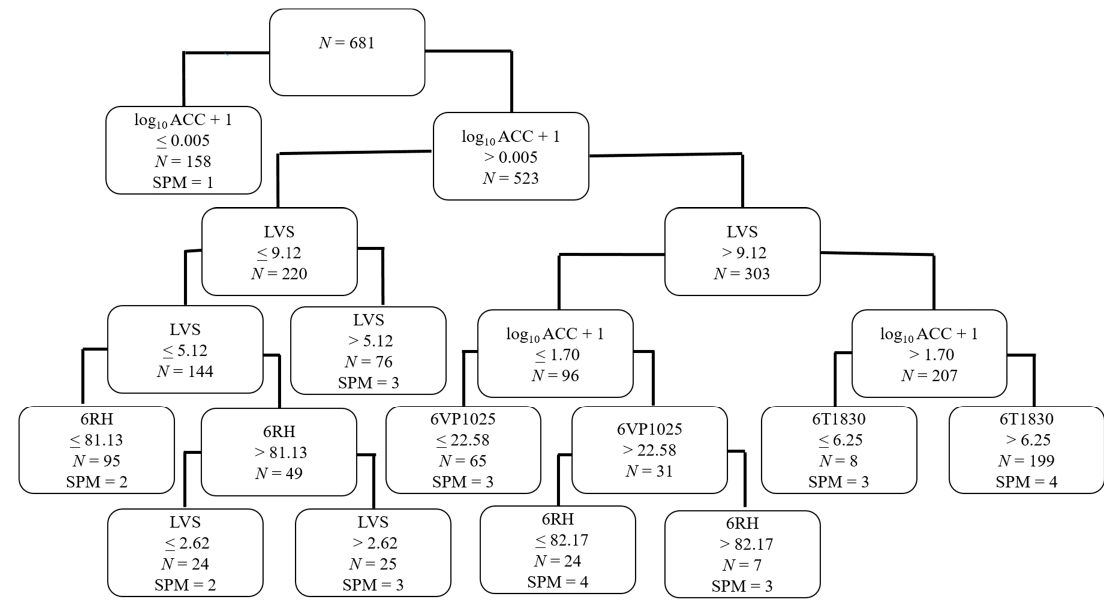
Figure 4. Representation of the classification tree built with airborne inoculum concentration (log 10 ACC + 1), number of susceptible leaves (LVS), mean % relative humidity during the previous six days (6RH), mean number of hours at temperature between 18 and 30 ◦ C during the previous six days (6T1830), and mean number of hours at saturation vapor pressure between 10 and 25 mmHg during the previous six days (6VP1025).